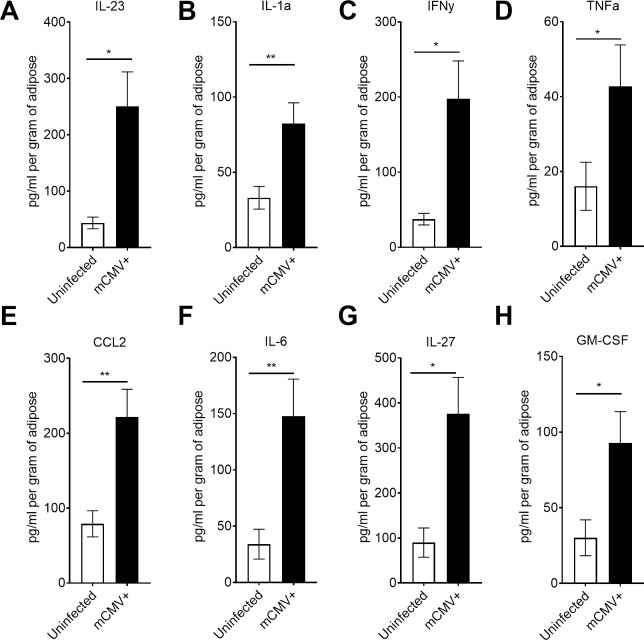
Lifelong mCMV infection results in inflammation in the adipose tissue.12-week-old C57BL/6J mice were injected with 105 pfu of mCMV and sacrificed at greater than 450d p.i.. Total adipose tissue was homogenized and analyzed by BioLegend LegendPlex. (A) IL-23 (B) IL-1α (C) IFNγ (D) TNFα (E) CCL2 (F) IL-6 (G) IL-27 and (H) GM-CSF were all statistically increased. Data are pooled results of two independent experiments. n = 9 uninfected and 10 infected animals total. Error bars represent mean ± SEM. *p < 0.05; **p < 0.01; ***p < 0.001; **** p ≤ 0.0001 by unpaired two-tailed Mann-Whitney U test.